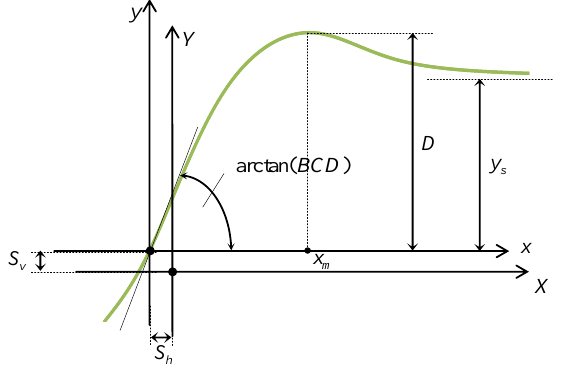
Figure 15. A graphical presentation of Pacejka’s Magic Formula.